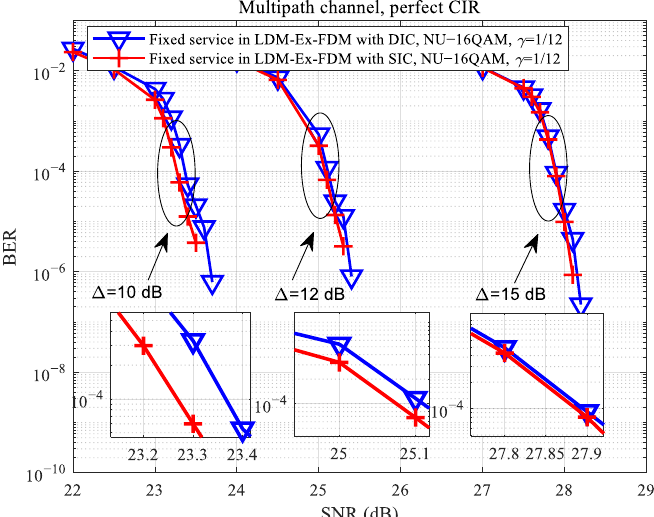
Figure 19. BER performance of fixed service in the LDM-Ex-FDM scheme with direct interference cancellation (DIC) and successive interference cancellation (SIC) with perfect channel impulse response (CIR) under the multipath channel, where the parameters of the ATSC 3.0 system were set to ∆ = 10 dB, 12 dB, 15 dB, the CL constellation was set to QPSK, the EL constellation was set to NU−16QAM, and the puncturing rate was set to 1/12.